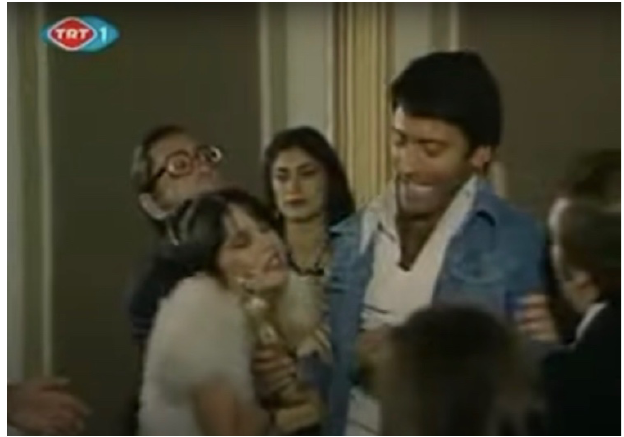
Figure 2: Orhan crashes the award ceremony while drunk